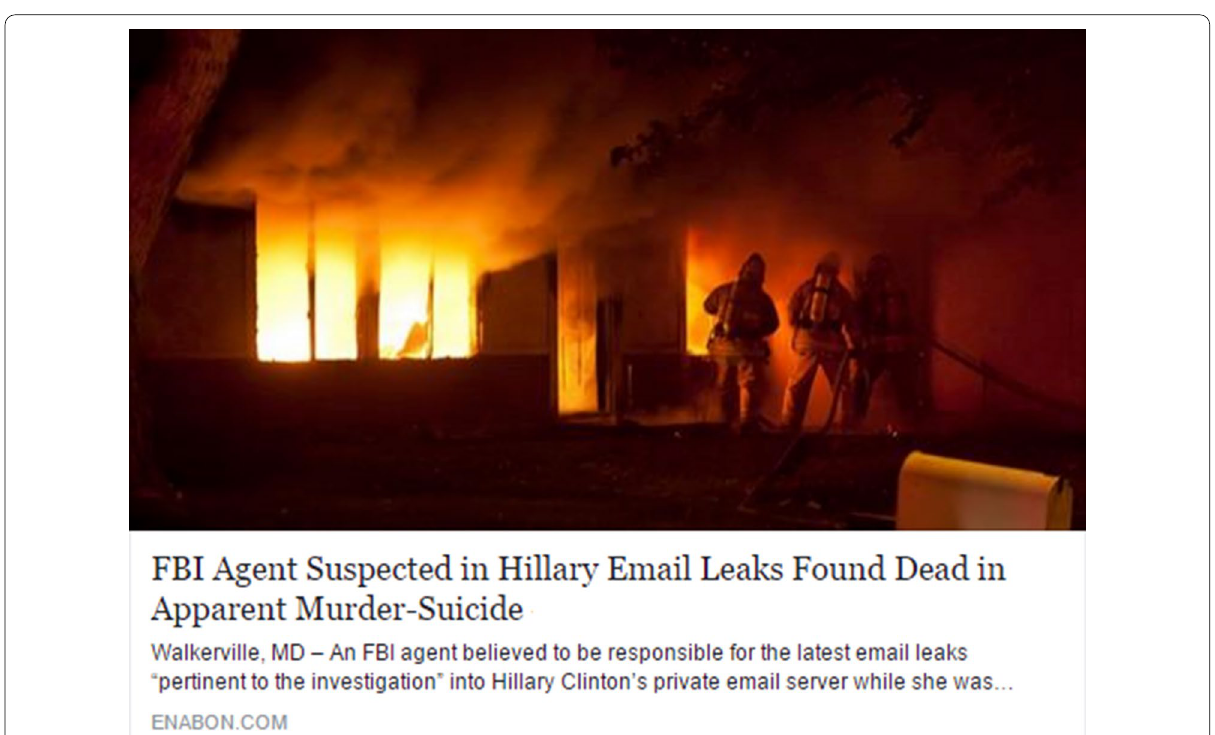
Fig. 1 Example article with picture, headline, byline, and source. Our news items are available online (https ://osf.io/gm4dp /?view_only 4d708 6d469 cb421 beb4c 66595 56)